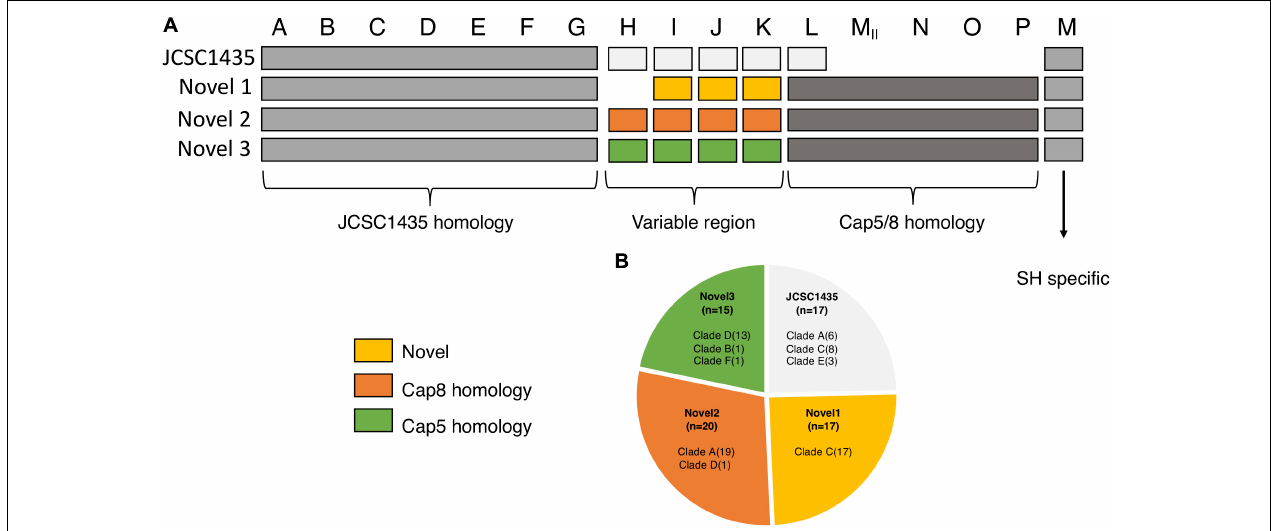
FIGURE 4 | Organization of the different polysaccharide capsules (CP) operons identified in our collection. (A) The three novel varies in their homology to the CP in JCSC1435. capA-G is homologs among all isolates with identified capsule operon. The region capH-K is what separates the four types from one another; novel 1 with no known homology, novel 2 shows homology to S. aureus cap8 and novel 3 with homology to S. aureus cap5 . The region capL-P is homologs to S. aureus and is found in all three novel types, a region absent in JSCS1435. (B) Pie chart showing the distribution of all identified CP operons in this study.